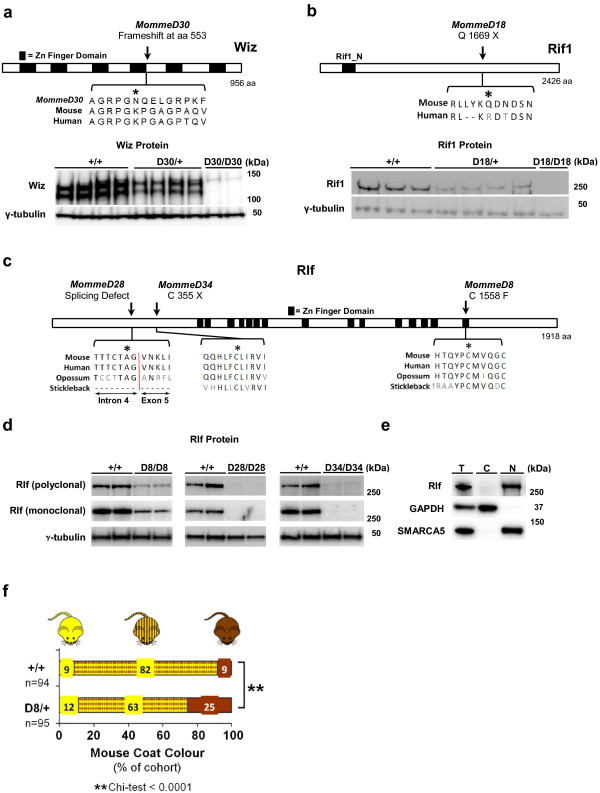
Causative mutations in MommeD30, MommeD18, MommeD8, MommeD28 and MommeD34. (a)MommeD30 carries a 1 bp deletion in Wiz that leads to a frame-shift at amino acid 553. Western blot analysis of embryo heads at 12.5 days post-coitum (dpc) shows reduced levels of Wiz protein in WizMommeD30 heterozygotes and no Wiz protein in homozygotes. Wiz protein was detected at approximately 120 and approximately 130 kDa. Each track represents a different animal. Tubulin was used as a loading control. (b)MommeD18 harbors a point mutation in Rif1 that introduces a premature stop codon at amino acid 1,669. Western analysis of testes tissue shows that RifMommeD18 heterozygotes have a reduced dosage of Rif1. No Rif1 protein was detected in a homozygote. Each track represents a different animal. Rif1 protein was detected at approximately 260 kDa and Tubulin was used as a loading control. (c) ENU point mutations in MommeD8, MommeD28 and MommeD34 occur in conserved regions of the Rlf protein. Asterisks indicate mutation. (d) Western blotting of Rlf in embryo head lysates from 14.5 dpc Rlf+/+, RlfMommeD8/D8, RlfD28/D28 and RlfD34/D34 revealed greatly reduced amounts of Rlf protein. Each track represents a different animal. Rlf protein was detected at approximately 280 kDa. Tubulin was used as a loading control. (e) Total, cytoplasmic and nuclear fractions of HeLa cells were isolated and protein concentration quantified. Equal amounts of each fraction were immunoblotted with anti-Rlf, GAPDH (cytoplasmic marker) and SMARCA5 (nuclear marker) antibodies, revealing nuclear localization of RLF. Rlf protein was detected at approximately 280 kDa, GAPDH protein at 37 kDa and SMARCA5 at approximately 120 kDa. (f) Coat color of offspring carrying the Avy allele produced from a RlfMommeD8 heterozygous female crossed to a pseudoagouti Avy male. RlfMommeD8 heterozygous offspring showed a shift in coat color towards pseudoagouti compared to wild-type littermates.